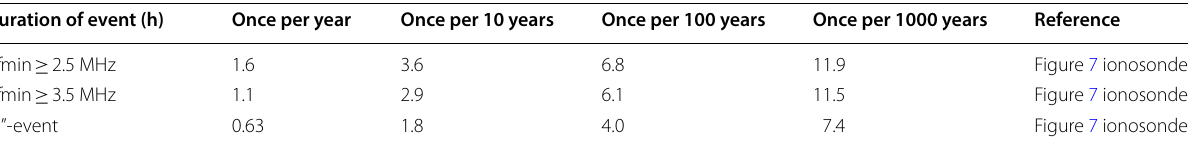
Table 2 Estimated duration for extreme events